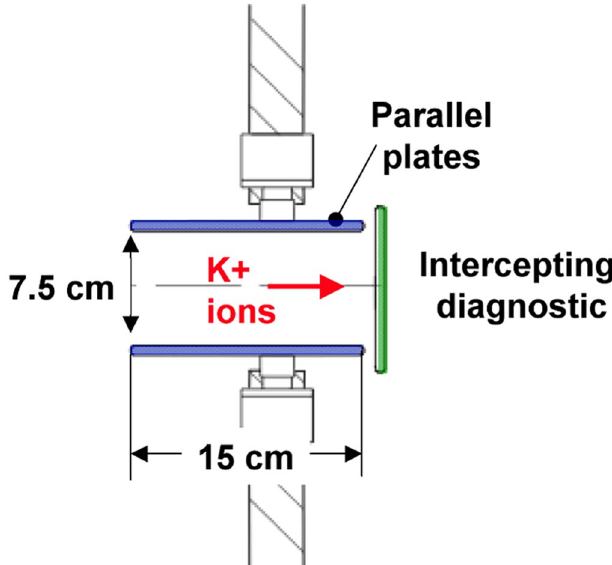
FIG. 15. (Color) Sketch of the experimental setup using the parallel plates and intercepting diagnostic to measure beam- induced gas desorption, ionization, and electron